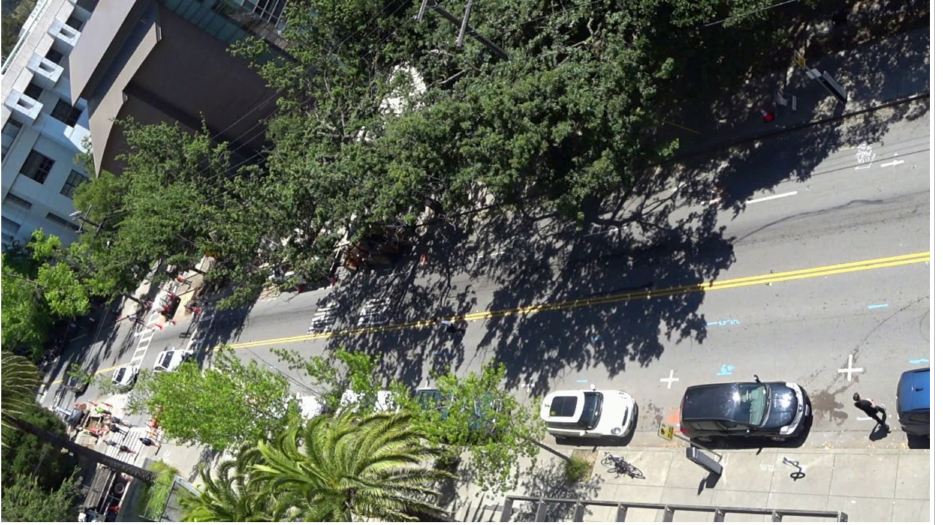
Figure 4. Example of monitoring scene in dataset. The camera was mounted on the top of a building with a top-down view of the